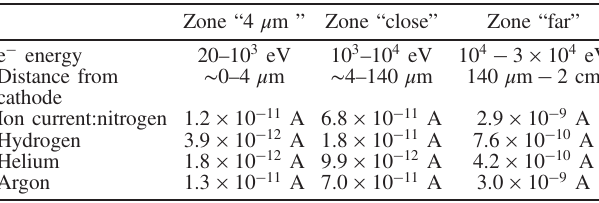
TABLE I. Summary of ionic current